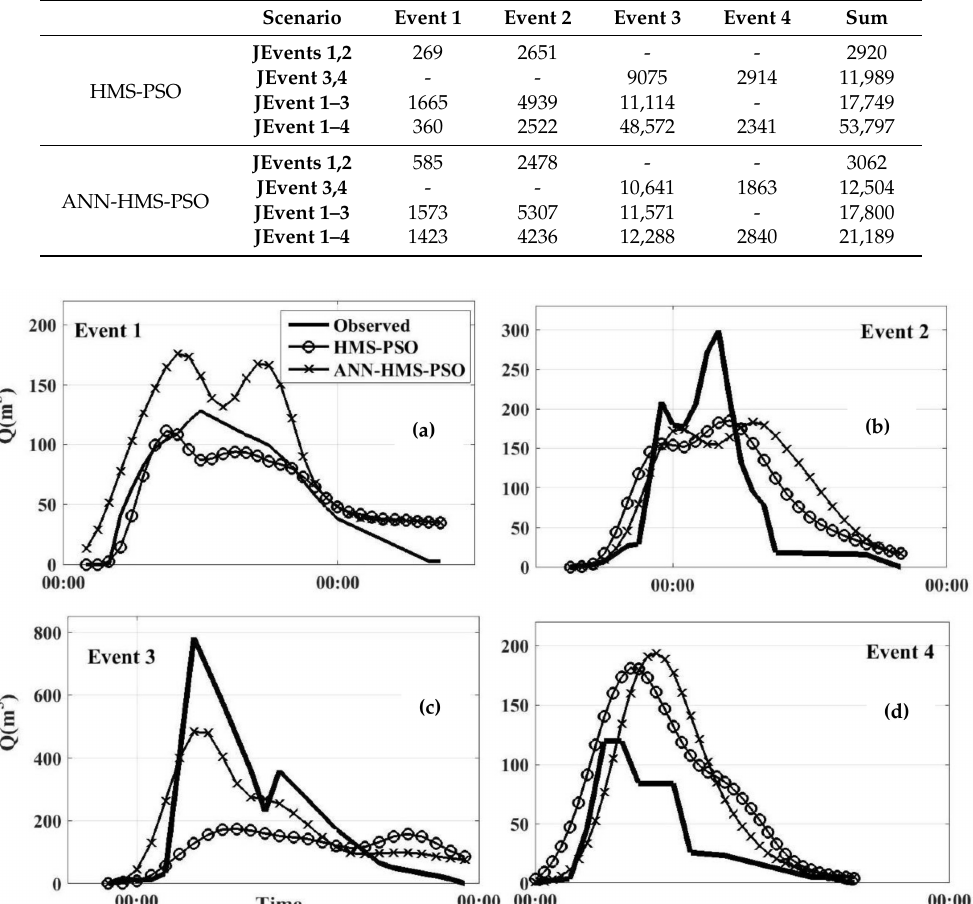
Table 4. The MSE values for jointly event scenarios using HMS-PSO and ANN-HMS-PSO models.